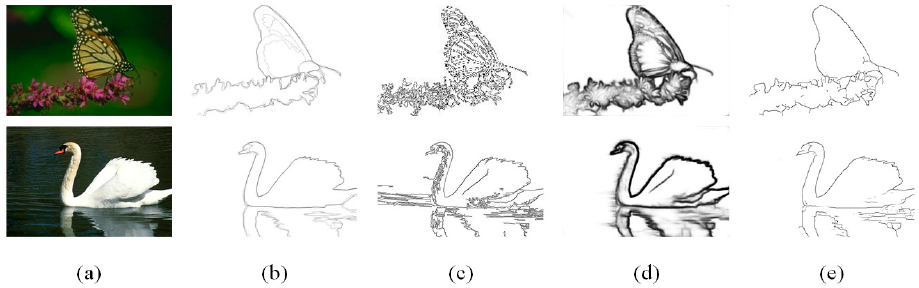
Figure 1. ( a ) Are example images from the BSDS500 dataset; ( b ) are the ground truths; ( c ) are the results of the Canny detector; ( d ) are the outputs of the HED detector; and ( e ) are the outputs of our proposed method. All the results do not apply post ‐ processing.